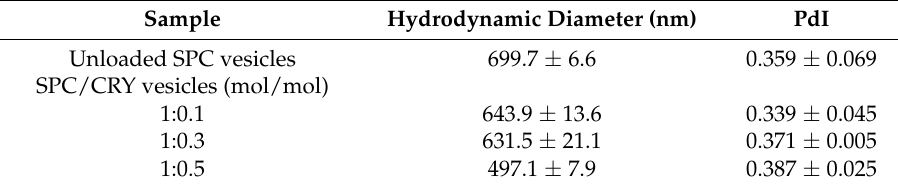
Table 2. Physicochemical features of SPC multilamellar vesicles (MLV) liposomes.